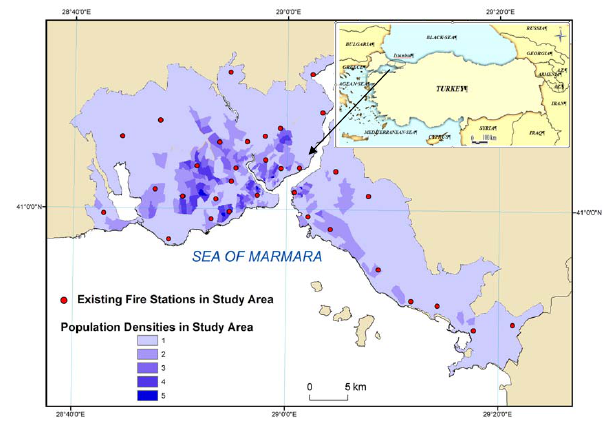
Figure 1. Study area with population densities and existing fire stations. Fig. 1. Study area with population densities and existing fire